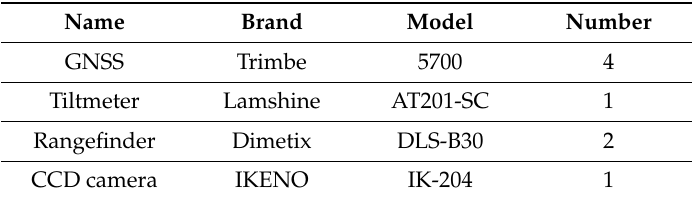
Table 1. All of the sensors used for the case study.